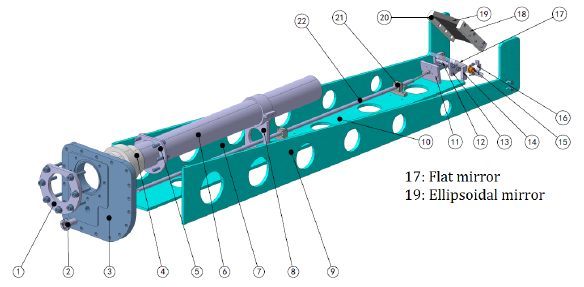
Figure 6. QO antenna of the CECE diagnostic.